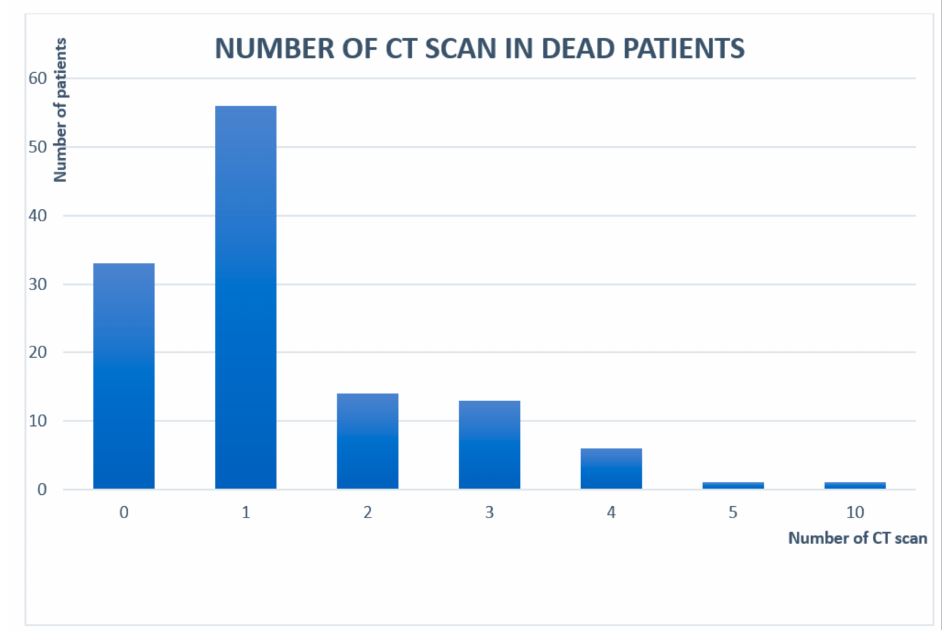
Figure 2. Number of CT scans performed in patients who died from